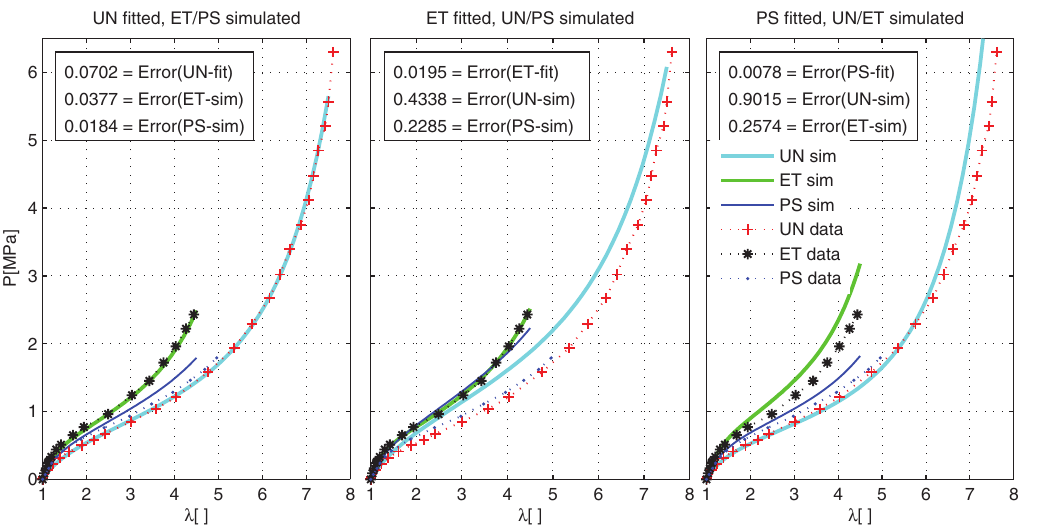
Figure 4: Comparison between the GD model and the Treloar data. Fitting to the analytical formulations and model prediction quality are excellent, especially in UN and PS. Only predictions for the EB-fitted parameters overestimate the UN and PS